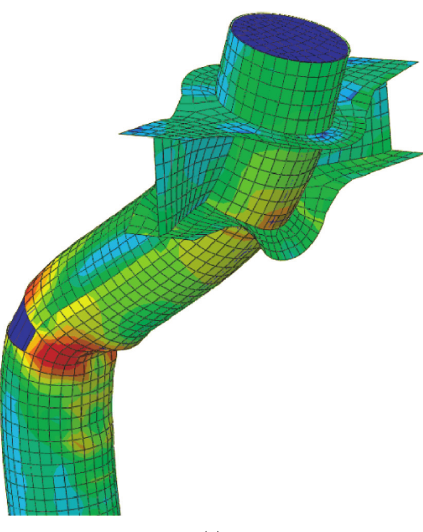
Figure 9: The collapse process by the DS method. (a) Local deformation of column failure. (b) Large deformation of column failure. (c) Failure deformation of the column and